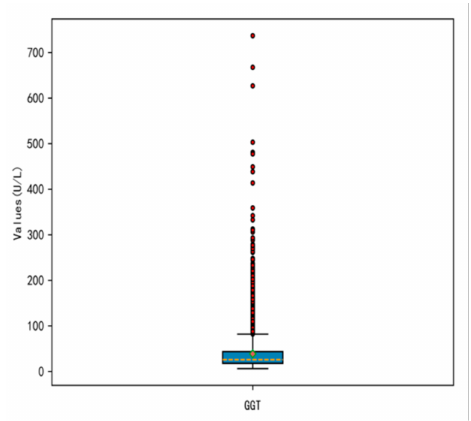
Figure 4. Boxplot of γ